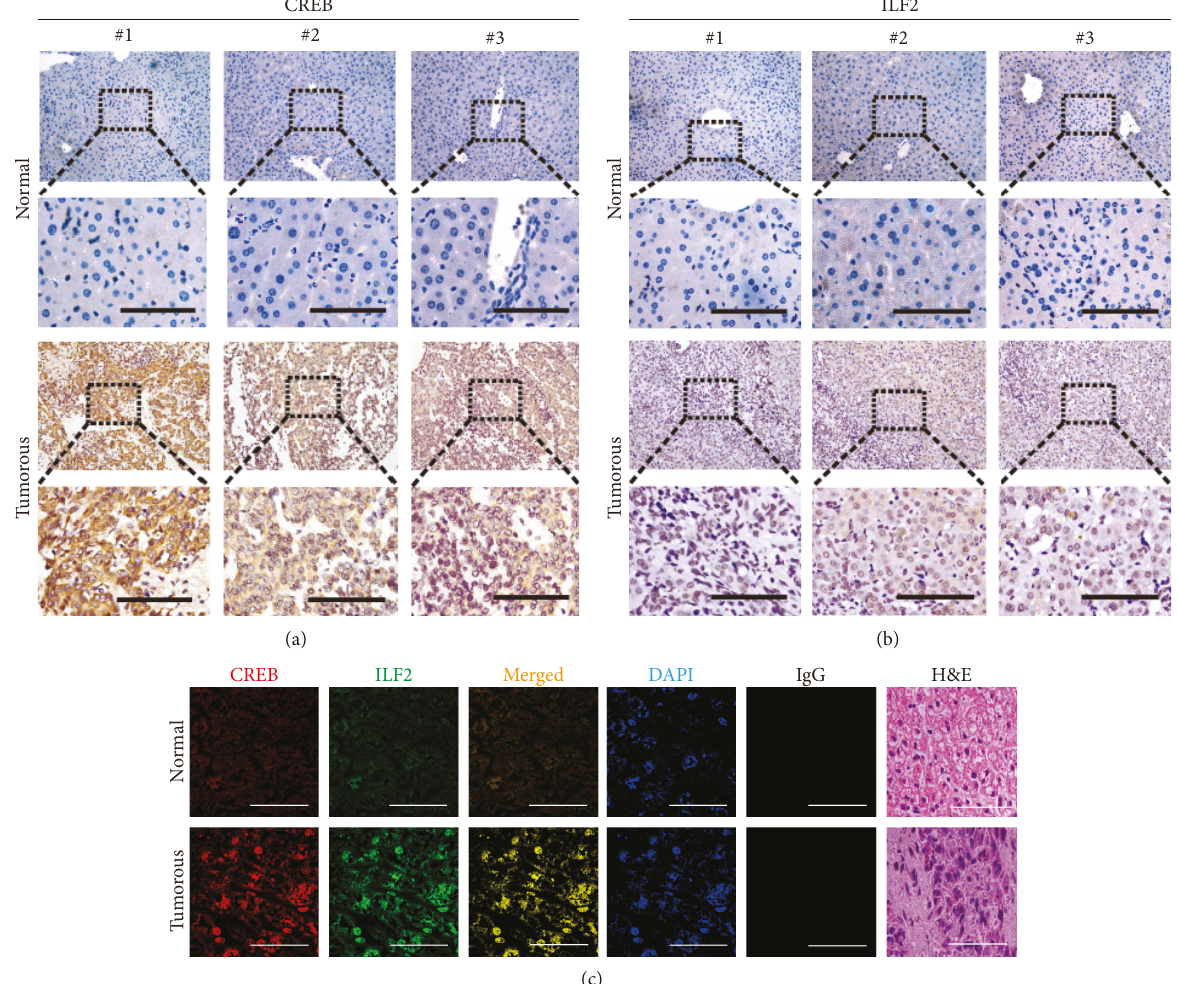
Figure 2: CREB interacts with ILF2 in liver cancer. (a, b) IHC staining of CREB and ILF2 expression in liver cancer tissues and adjacent noncancerous tissues. Scale bar, 500 μ m. (c) The subcellular localization of CREB and ILF2 in liver cancer tissues and adjacent normal liver tissues was measured by IF. Representative images of three independent experiments were shown. The rightmost graphic was the H&E staining of tissue sections. Scale bar, 15 μ